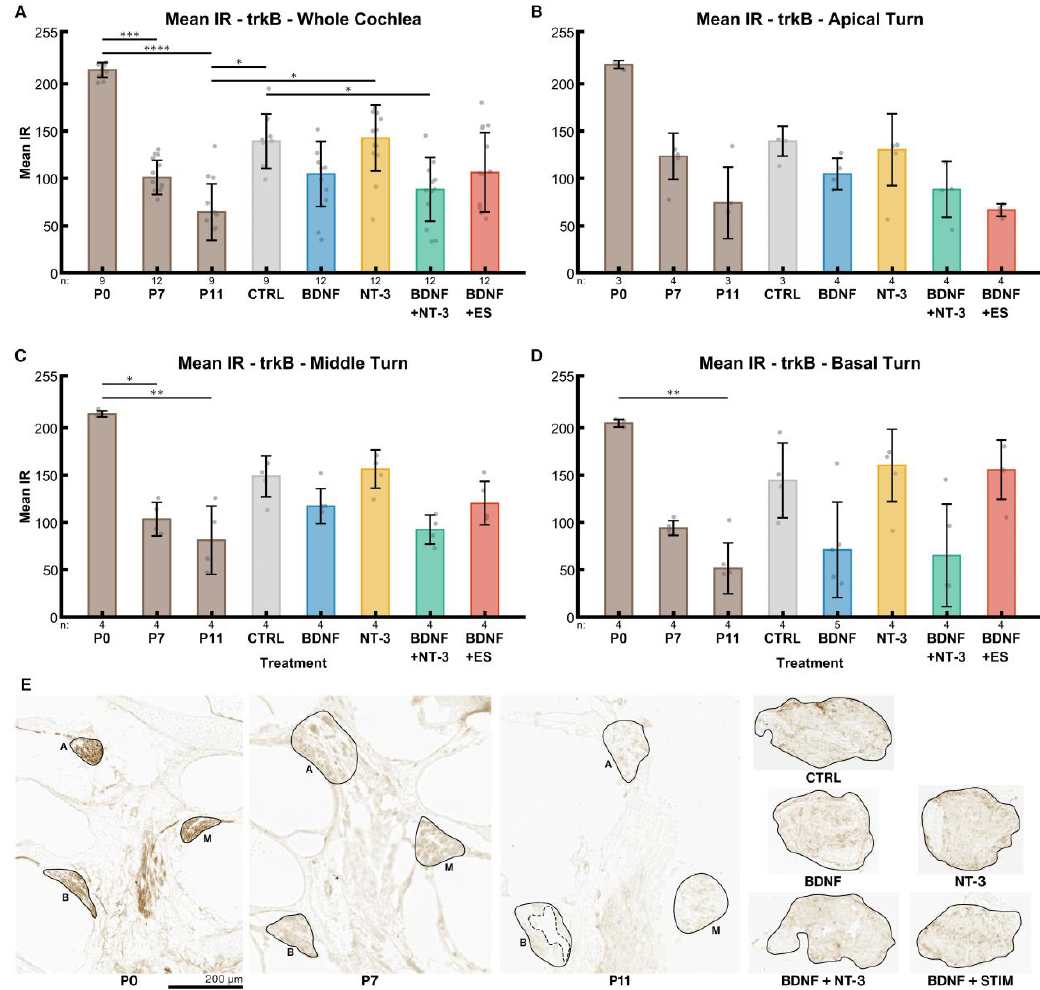
Figure 6. TrkB receptor expression. The diagrams ( A – D ) show the mean IRs of DAB-positive areas of histological sections in different age groups (P0 – P11) and explants after different treatments (untreated (NT CTRL), 25 ng/mL BDNF, 200 ng/mL NT-3, 25 ng/mL BDNF + 200 ng/mL NT-3 and 25 ng/mL BDNF + 500 µ A). The groups in the first graph ( A ) contain an equal number of samples from three turns, hence representing the whole cochlea. Diagrams ( B – D ) depict the individual turns. ( A – D ) The whiskers denote the standard deviation. Individual samples are marked as grey dots. The number of samples in each group is written right below the X-axis. The asterisks or ns (not significant) above the groups indicate the significance level of a Kruskal–Wallis test followed by a Dunn’s multi- comparison post-hoc test. The DAB intensities of P0–P11 pups were tested among themselves, and the treated explants were compared with the control and the P11 group. Non-significant differences between groups are not highlighted. ( E ) Representative sections closest to the median mean IR of the groups in ( A ). The solid black lines mark the regions of interest, and the dashed line represents an exclusion area. A, M and B denote apical, middle, and basal turns, respectively. The explant sections are all from the middle